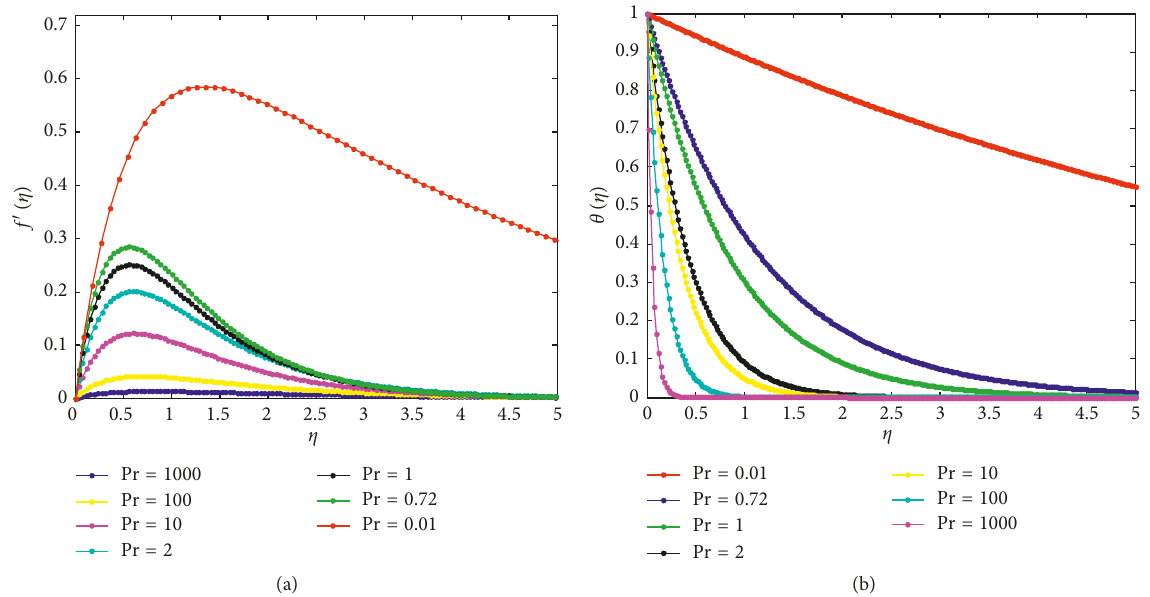
Figure 6: (a) Effects of Prandtl number on the velocity profile when ϕ � 0.020. (b) Effects of Prandtl number on the temperature profile when ϕ � 0.020.